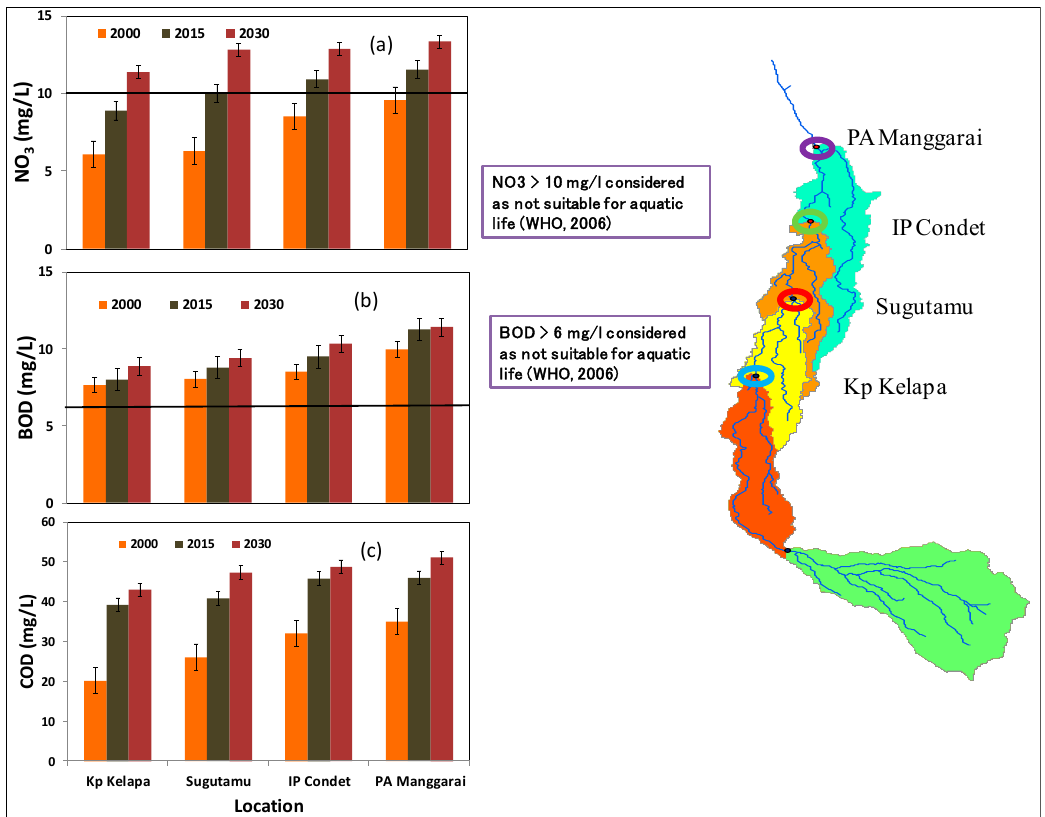
Figure 11. The simulation results of the annual average values of ( a ) NO 3 , ( b ) BOD and ( c ) COD for four different locations in 2000, 2015, and 2030 (scenario considering population growth and climate change with planned wastewater infrastructure for 2030).